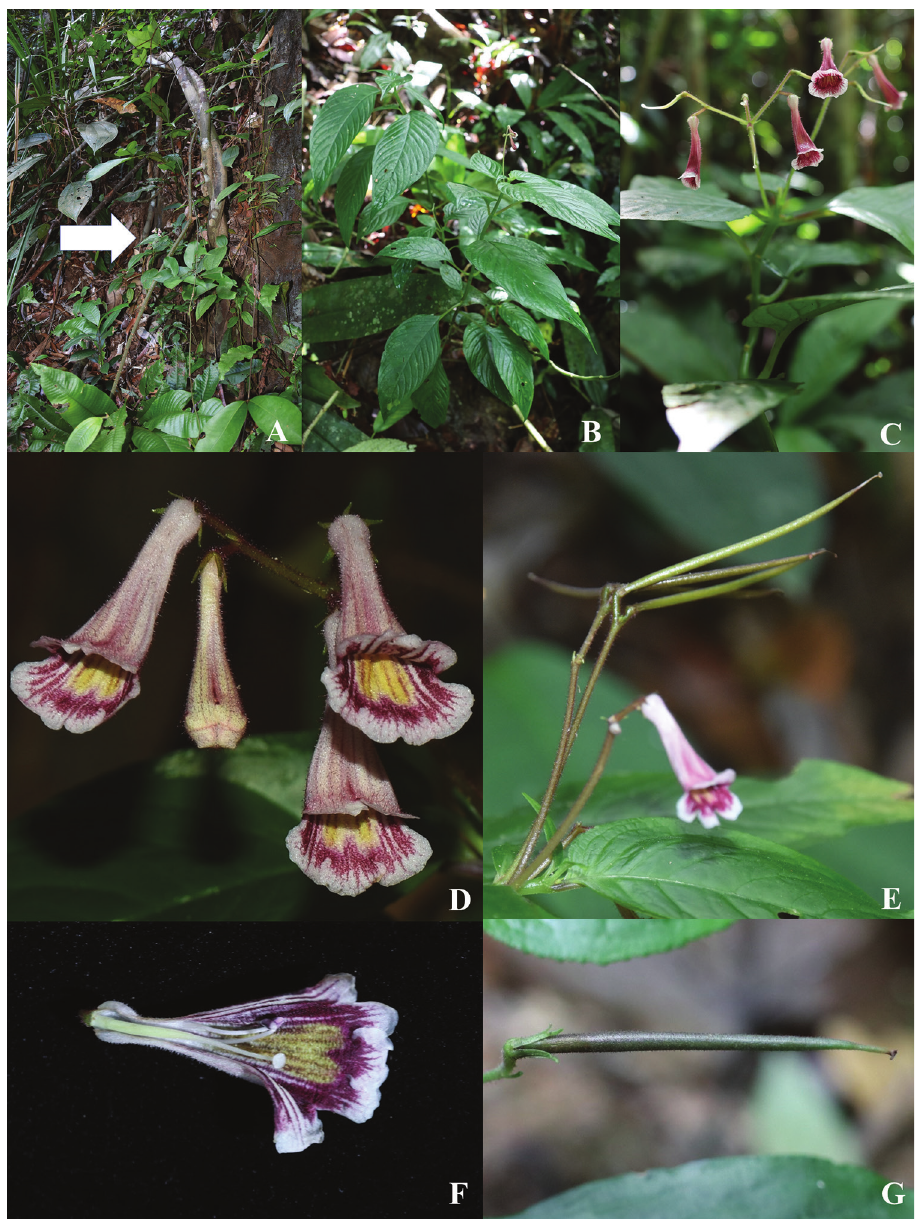
Figure 5. Codonoboea ruthiae Syahida-Emiza, Y.Y. Sam & Siti-Munirah. A habitat B habit C inflorescence with flower and pistil (corolla fallen) D flowers from front view e flower and fruits F longitudinal section of flower G